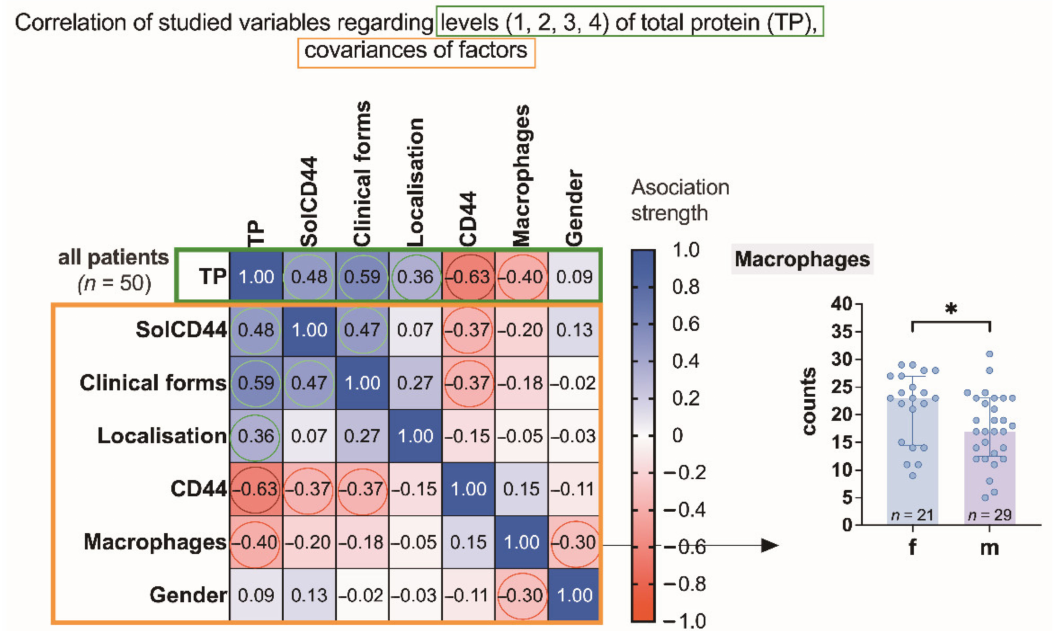
Figure 1. Association strength of studied variables: SolCD44, clinical forms of leukoplakia, localization of oral leukoplakia, mean number of CD44 expressed in epithelial layers in leukoplakia tissue, mononuclear cells (macrophages under the basal membrane), and gender of patients with leukoplakia ( n = 50) regarding levels of total protein (and covariances). Spearman’s rank correlation matrix: numbers in squared cells show value of correlation coefficient showing association strength; colored circles denote the most significant associations (red, negative; green, positive). Negative association between the number of macrophages and gender (f, female; m, male) is additionally represented by the scatter plot on the right. * p < 0.05 (unpaired t -test). The arrow indicates a decrease in the average value of the corresponding